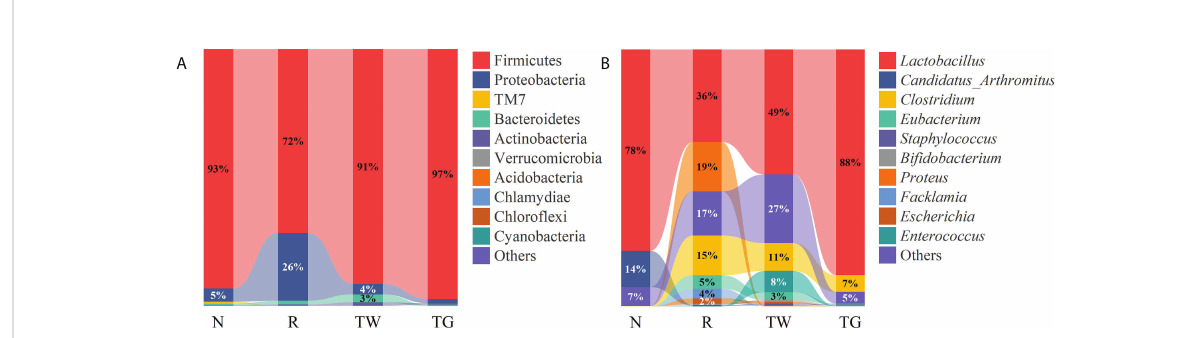
FIGURE 2 Effects of QWBZP-TG on the microbial structure in AAD mice. Relative mean abundance of small intestine microbiota at the (A) phylum and (B) genus levels in the four groups ( n = 7). N, normal control group; R, antibiotic-associated diarrhea (AAD) restore group; TW, Qiwei Baizhu Powder (QWBZP) decoction group; TG, total glycosides of Qiwei Baizhu Powder (QWBZP-TG) group.